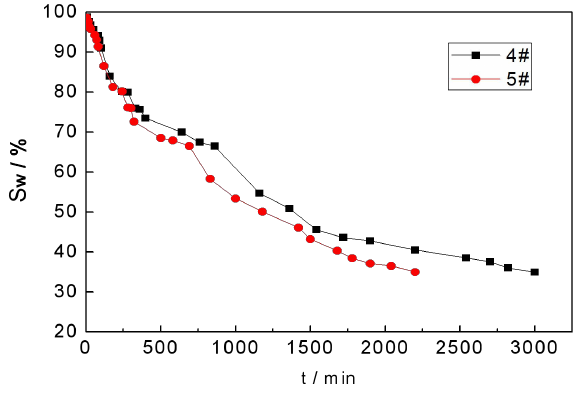
Figure 5—Saturation curves of 4# and 5#.